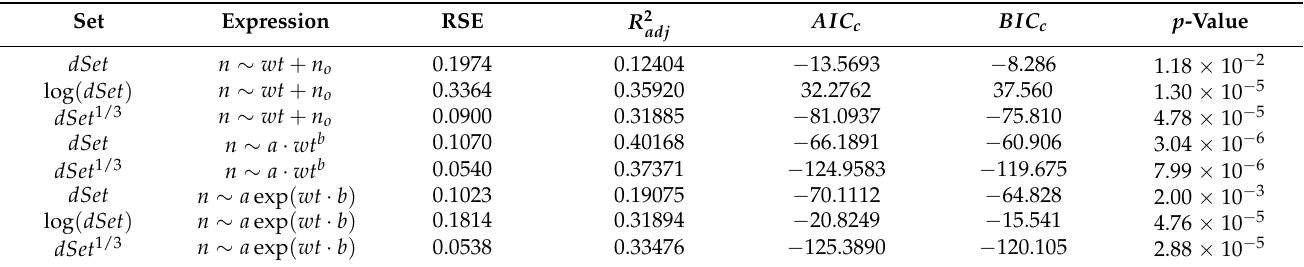
Table 12. Regression results for n vs. wt for the XG dataset.